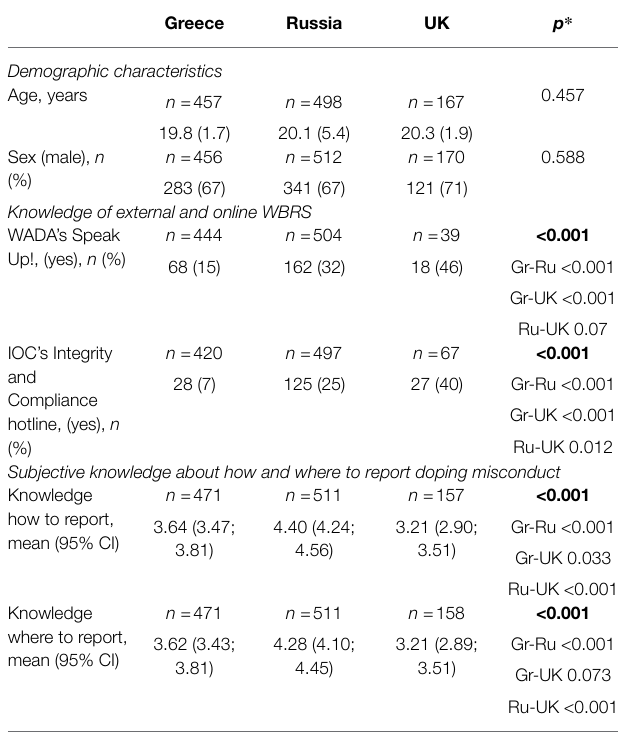
TABLE 1 | Participants’ descriptive characteristics, awareness of whistleblowing channels and knowledge on reporting doping misconduct across